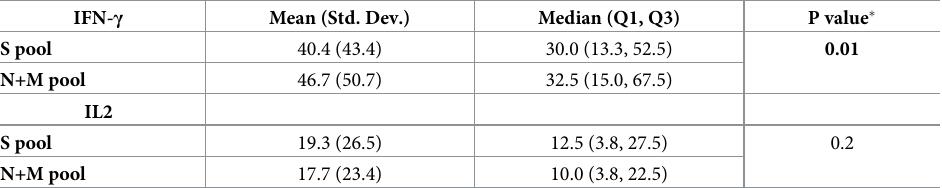
Table 4. Magnitude of IFN- γ and IL2 responses to the S and N+M peptide pools among all infected participants (N =